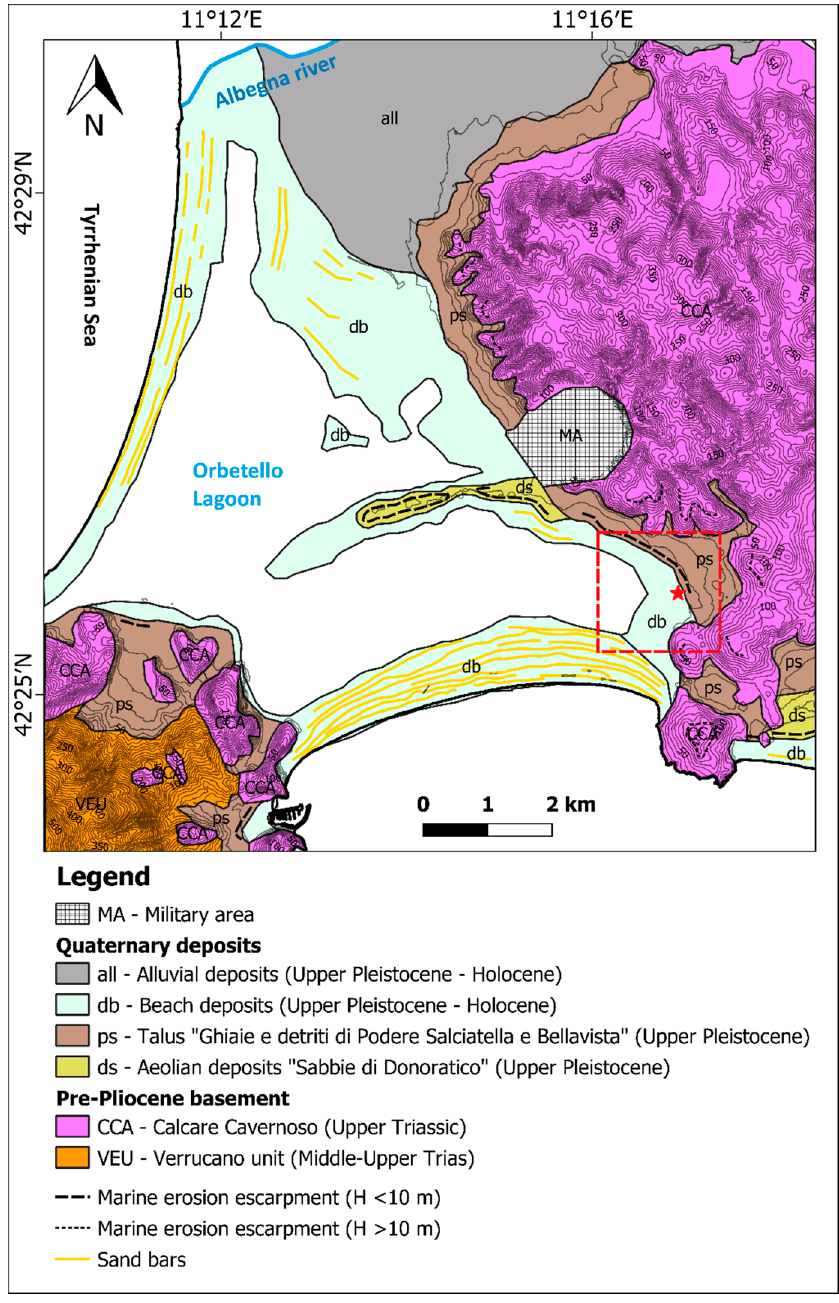
Figure 3. Schematic geological map of the Orbetello area (modified after [64]). The study area and the location of the sediment profile analyzed in this study are indicated, respectively, by the red square and star.